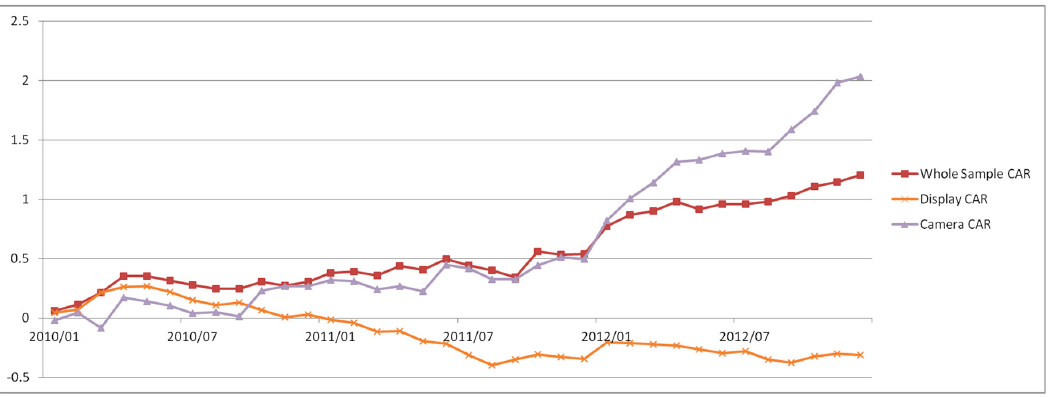
Figure 1. Average CAR for Evaluation period: 2007-2008, Event period: 2010–2012 3 . Table 2. Cross-correlation of average CARs for Evaluation period: 2007–2008, Event period: 2010–2012.